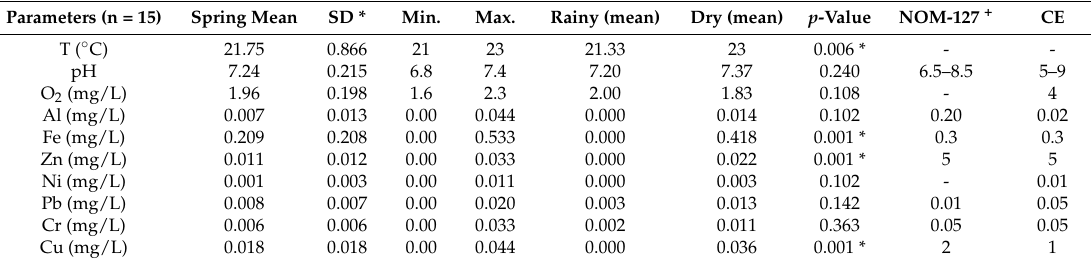
Table 2. Heavy metals in the spring water. Descriptive statistics, significance value of the Kruskal-Wallis Test for the comparison between rain and drought, and critical values according to two Mexican